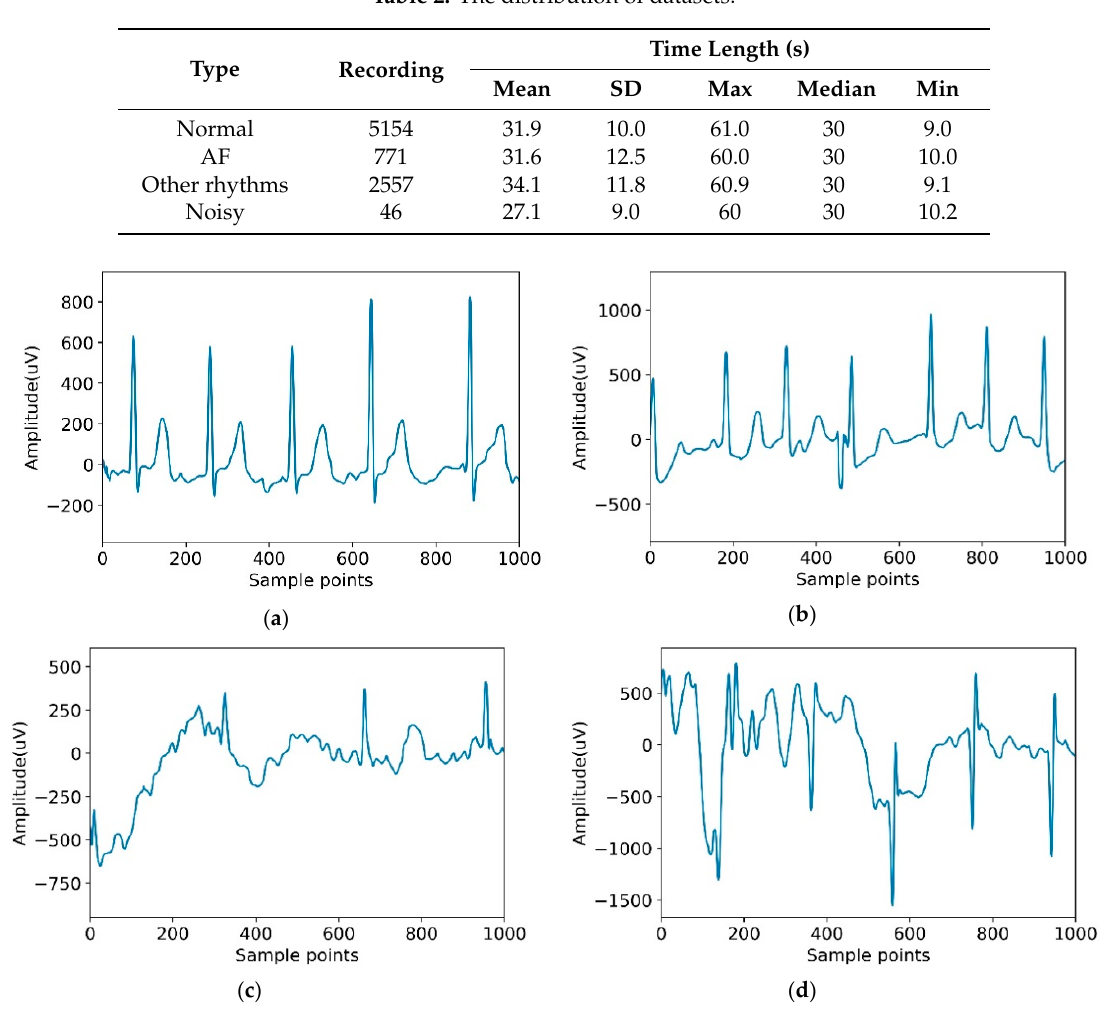
Table 2. The distribution of datasets.